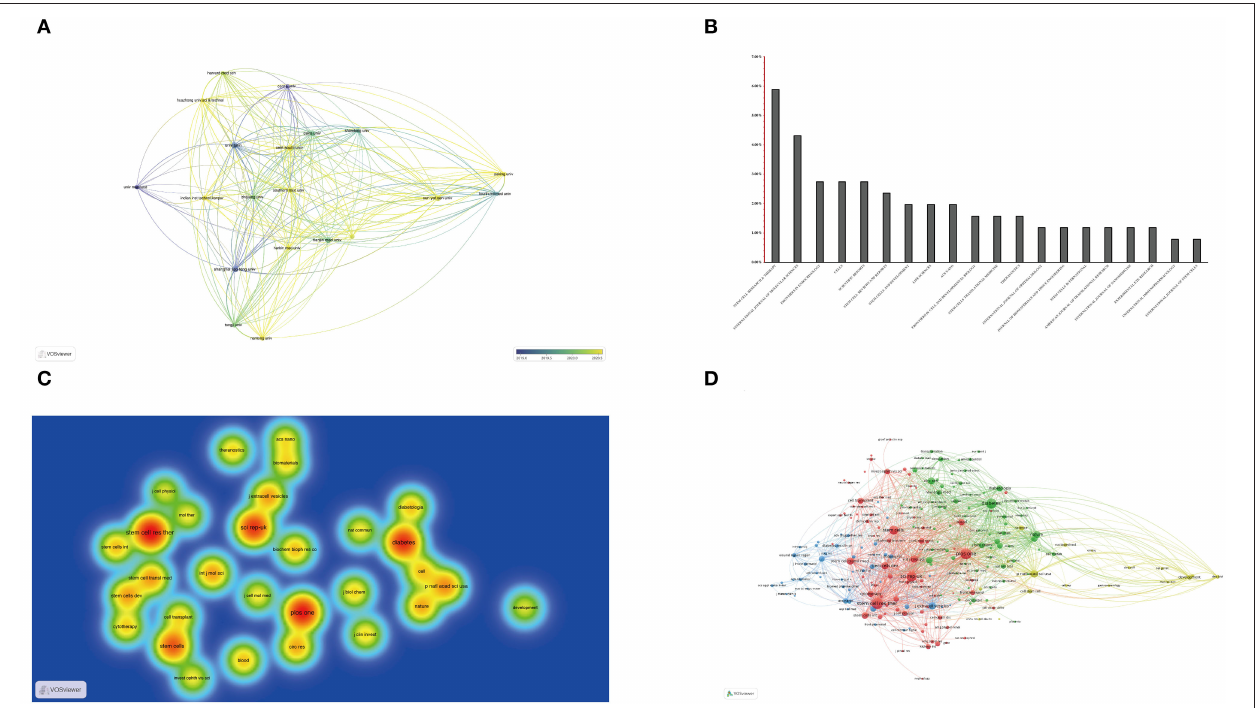
FIGURE 3 | Articles on SC-EVs for diabetes published in different institutions and journals. (A) Collaboration between institutions based on VOSviewer. (B) The top 20 journals produced the largest number of articles. (C) Density map of article reference distribution based on VOSviewer. (D) Network visualization of article reference distribution based on VOSviewer.